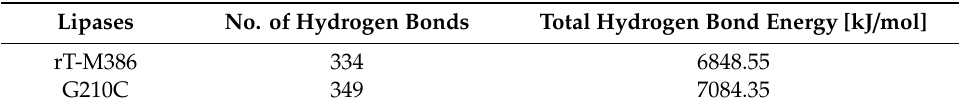
Table 1. Comparison between the total number of hydrogen bonds and energy of rT-M386 and G210C